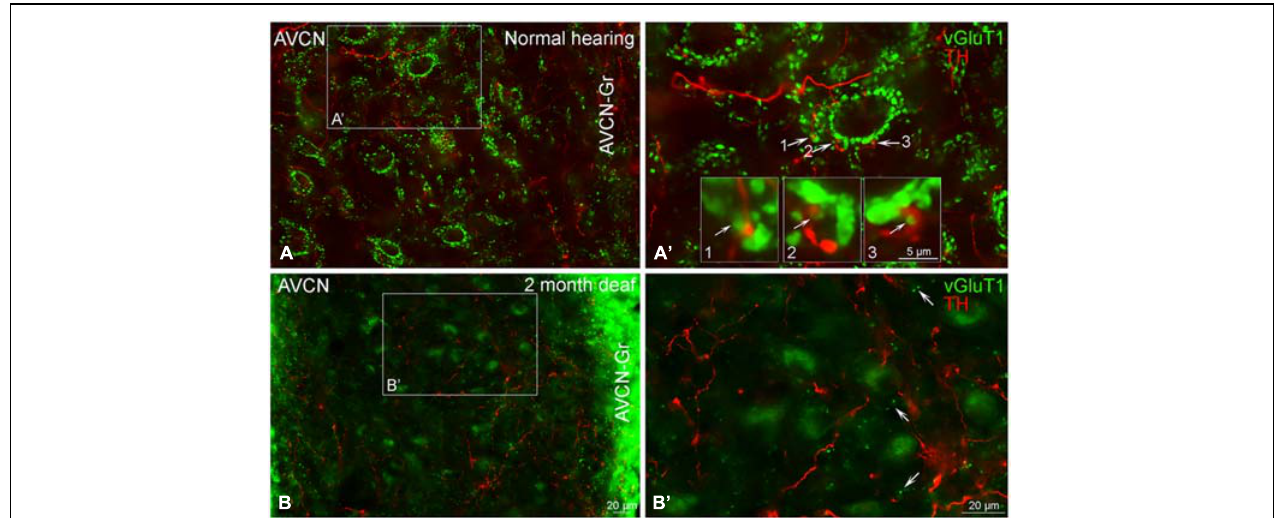
positive terminals are in close contact with TH positive en passant swellings ( A’ 1–3) little to no co-localization was observed. Following deafness, labeling for VGLUT1 becomes visible within cell bodies and smaller terminals (B,B’) . Scale bar – 5 μ m in boxes labeled 1, 2, and 3. Scale bar: 20 μ m (A,A’,B,B’).